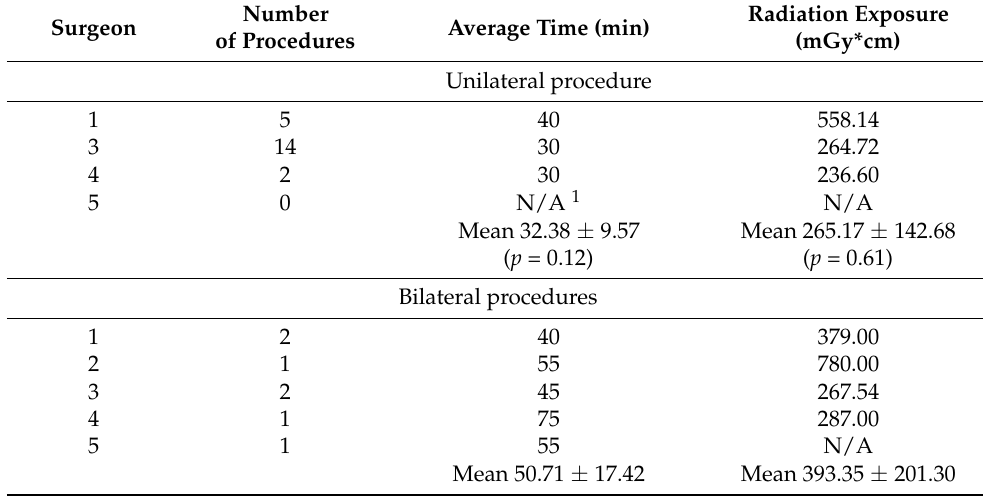
Table 2. Outcomes of unilateral and bilateral surgery (“surgeon 2” did not perform any unilateral procedure, hence was excluded from this